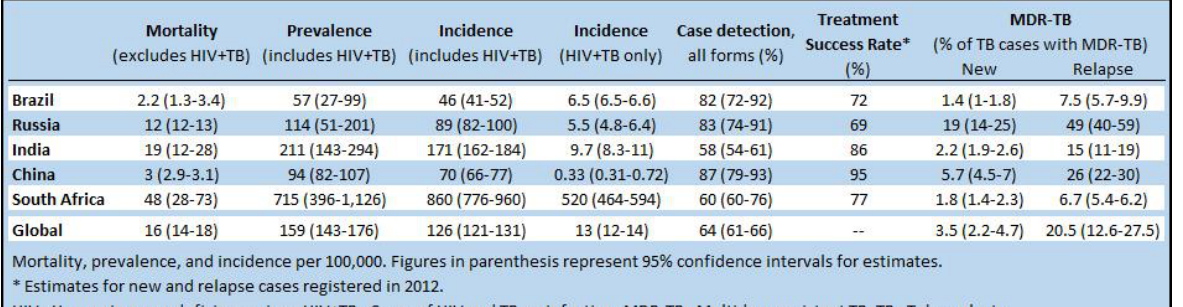
Table 1. Tuberculosis indicators for BRICS countries and globally,